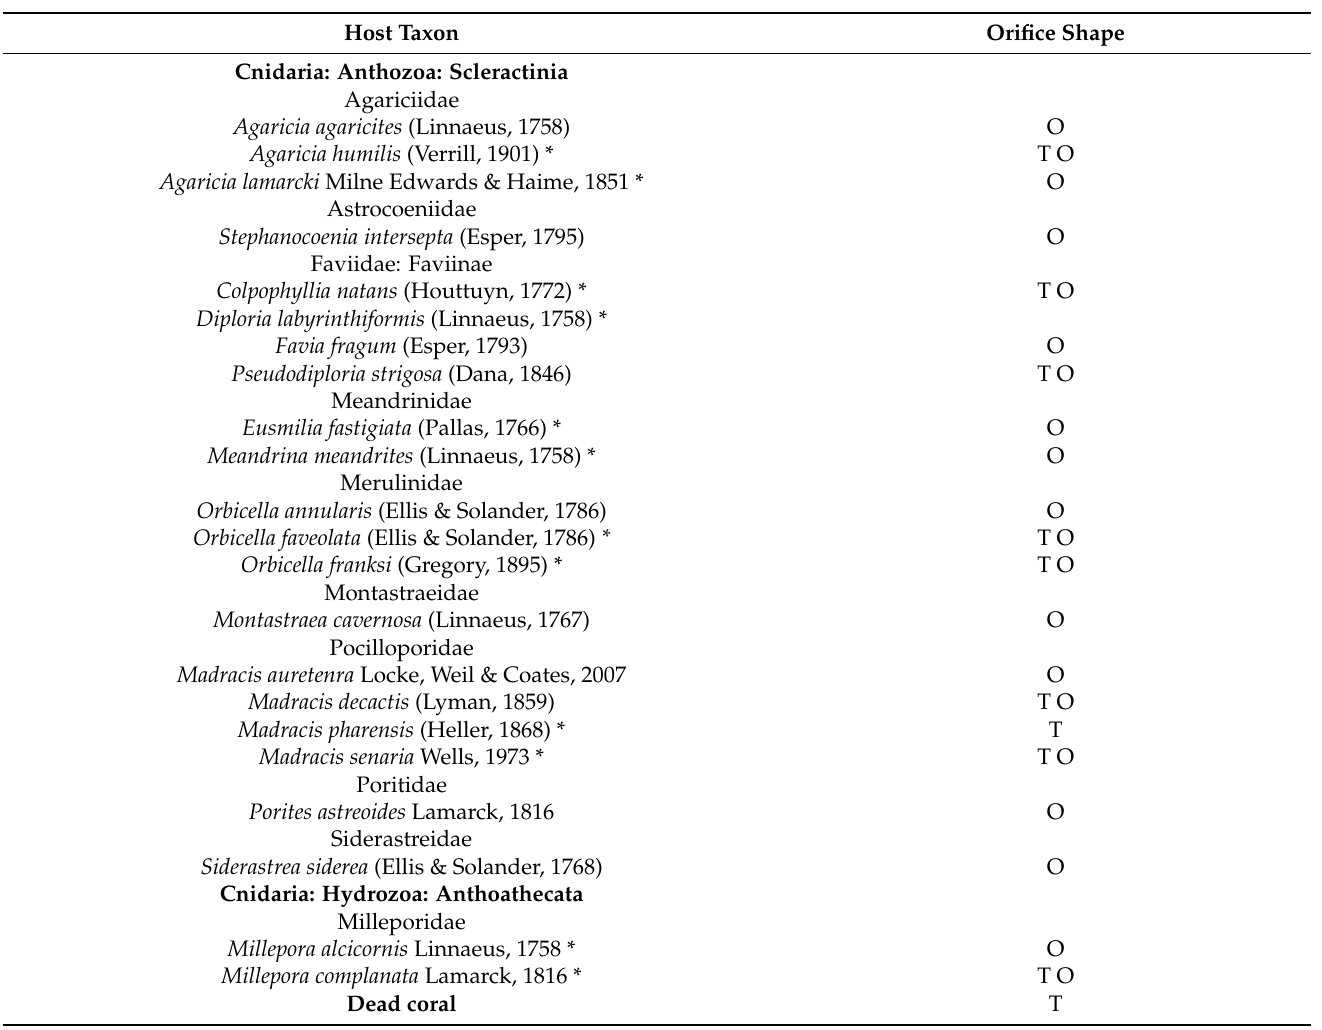
Table 1. Coral species at Curaçao observed as hosts for Leiosolenus ; * = new host record. Shape of orifices observed: T = figure of eight; O = other (oval, dumbbell, keyhole and ink